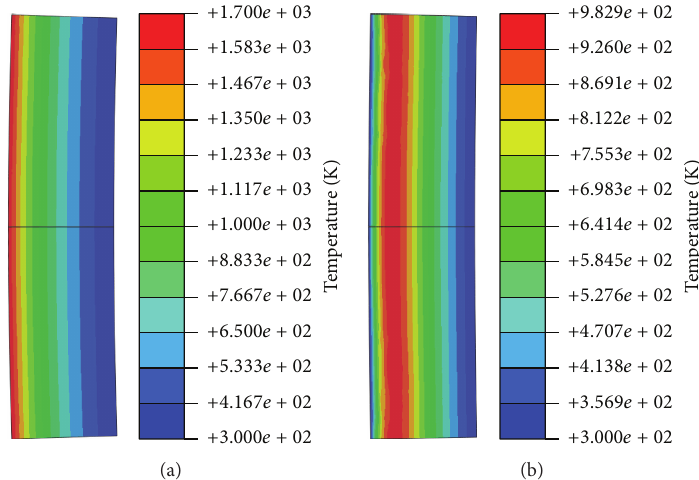
Figure 9: Contour plots of the temperature distributions: (a) steady state under heating and (b) transient state due to cooling at the end of analysis.